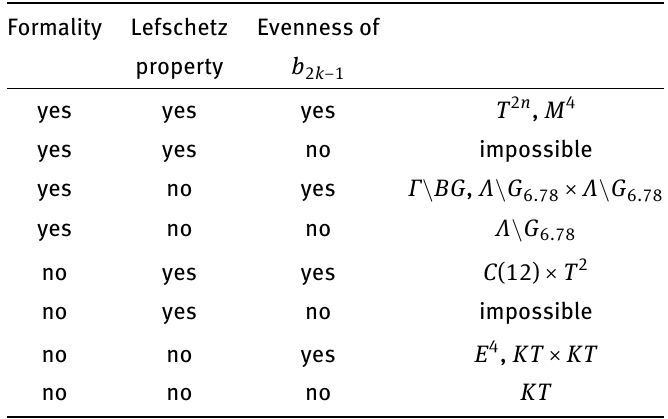
Table 1: Non simply connected symplectic